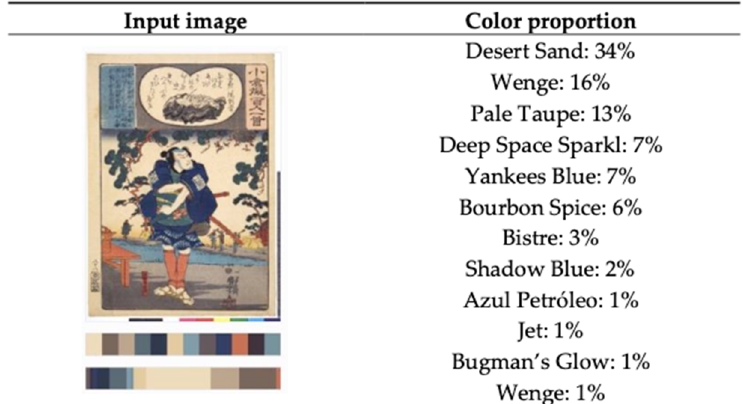
Figure 9. Example of color information extraction.